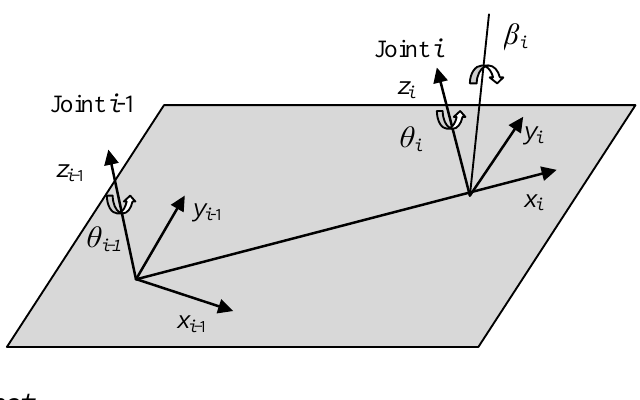
Figure 2. Model for two adjacent parallel